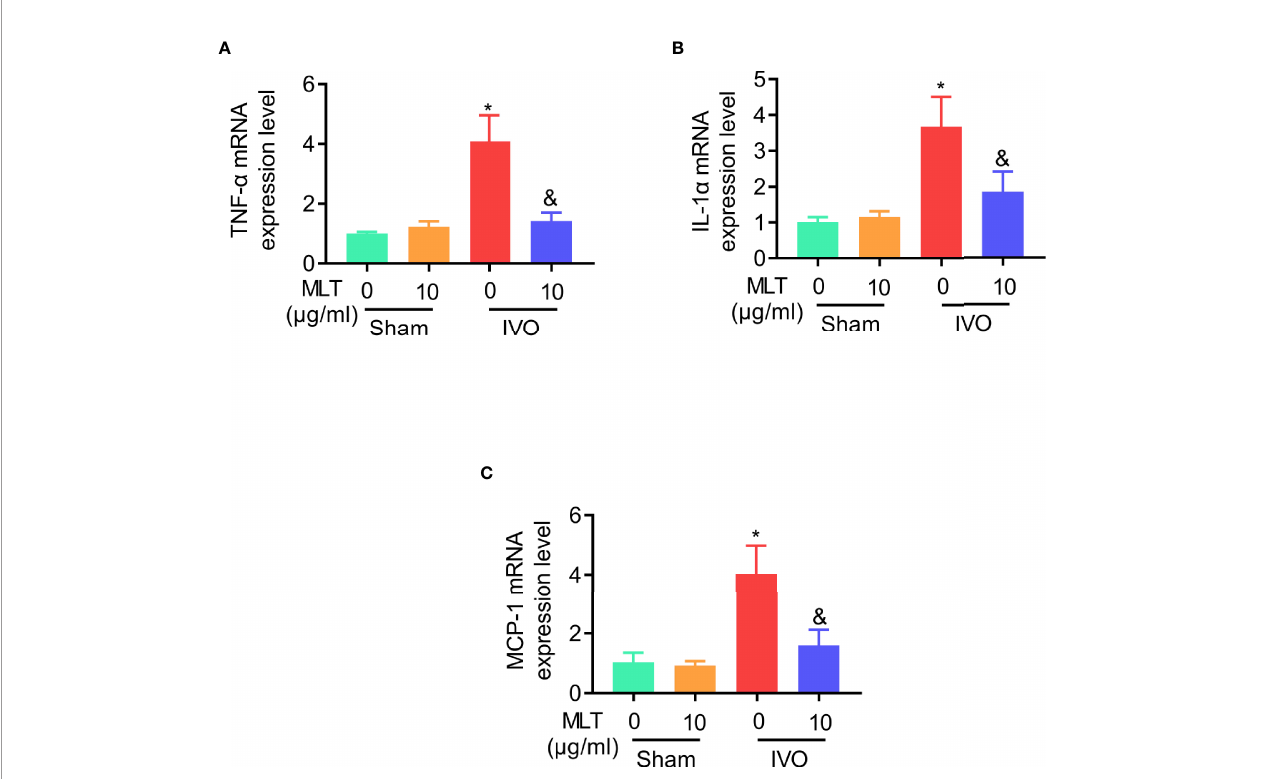
FIGURE 2 | MLT inhibits affected muscular in fl ammatory response in an IVO model. (A – C) Relative mRNA expression of TNF- a (A) , IL-1 a (B) , and MCP-1 (C) in gastrocnemius muscle was measured using real-time PCR. b -actin mRNA was used as an internal control, and expression was normalized to that of animals in sham/NS group. Sham/NS ( n = 4), sham/MLT ( n = 4), IVO/NS ( n = 4), and IVO/MLT ( n = 6). Values are presented as means ± SD. * p < 0.05 vs. sham/NS, & p < 0.05 vs.